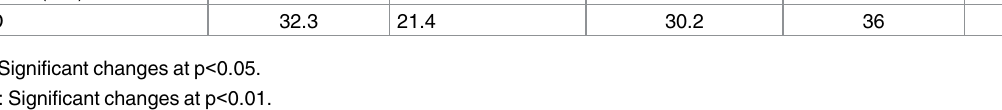
PLOS ONE | https://doi.org/10.1371/journal.pone.0181623 July 20,